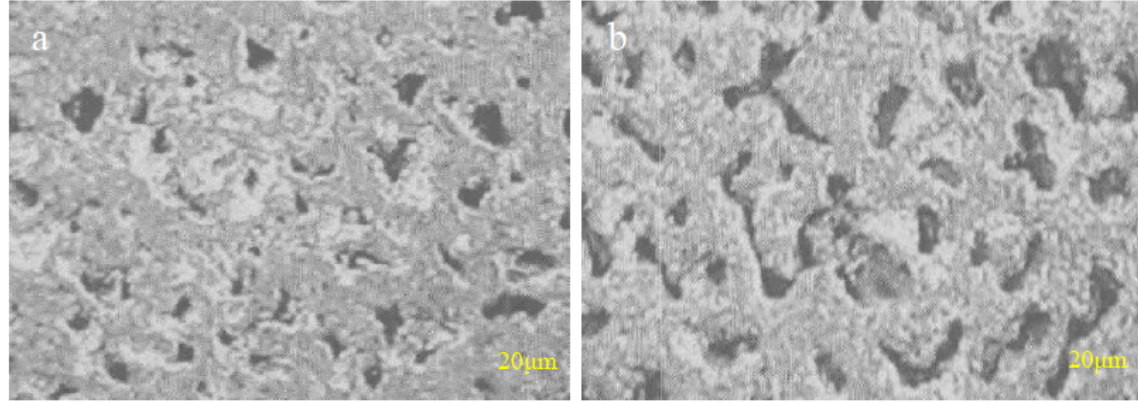
Figure 9: Tensile fracture morphology of the brazed joints comprising